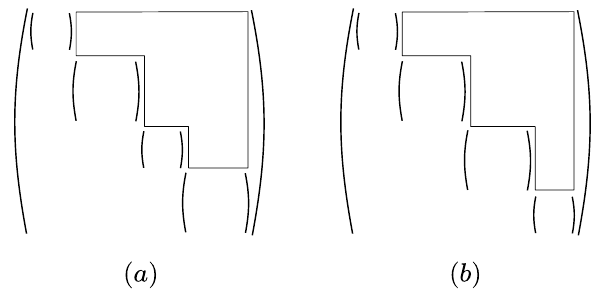
Figure 11 . The embedding of H t into G determines the set of positive roots in the coset. The positive roots are the holomorphic directions. Two such embeddings shown here lead to di(cid:11)erent sets of positive roots and, therefore, to di(cid:11)erent complex